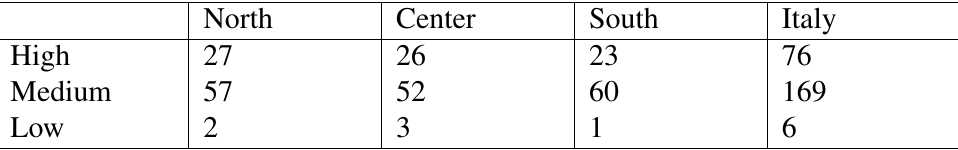
Table 6: Schools performance sorted in geographical